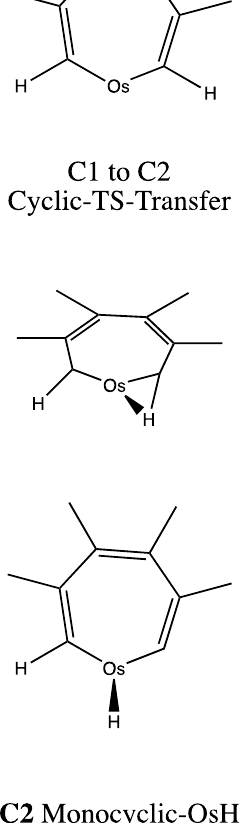
Figure 8. Landmarks for the first proton transfer to Os, which can take place on the cyclic scaffold (the Cyclic Path C, steps C1 to C2 )